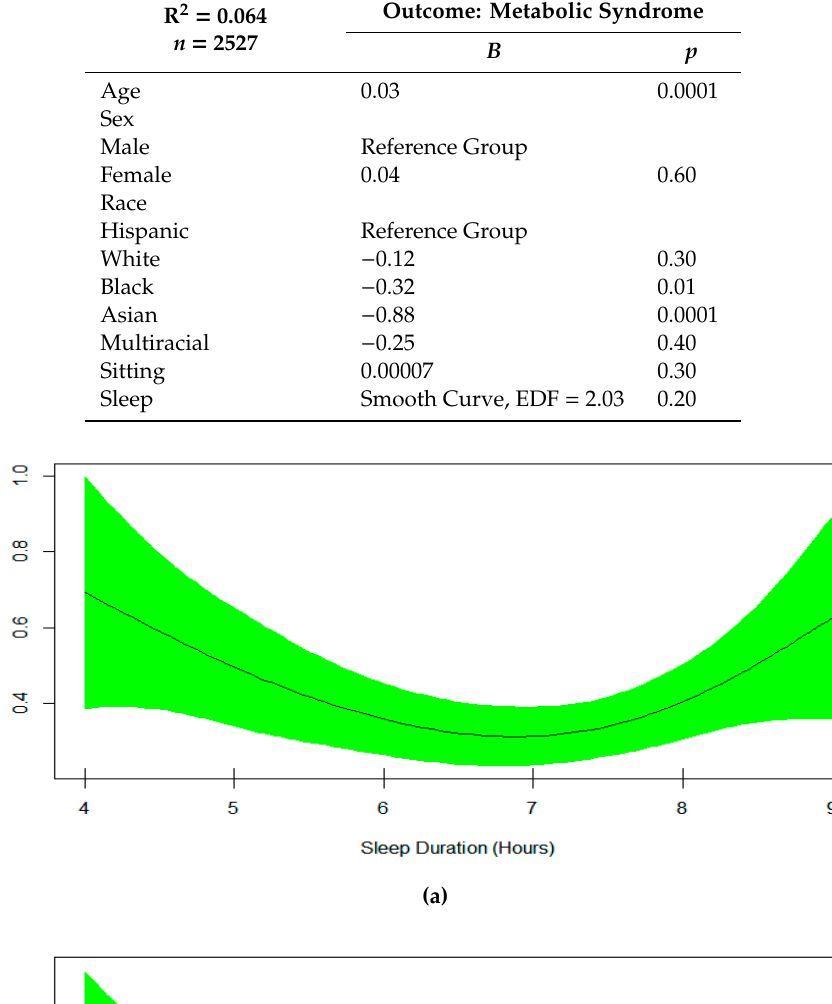
Table 2. Association of metabolic syndrome and independent variables measured by the multivariable generalized additive model 2.